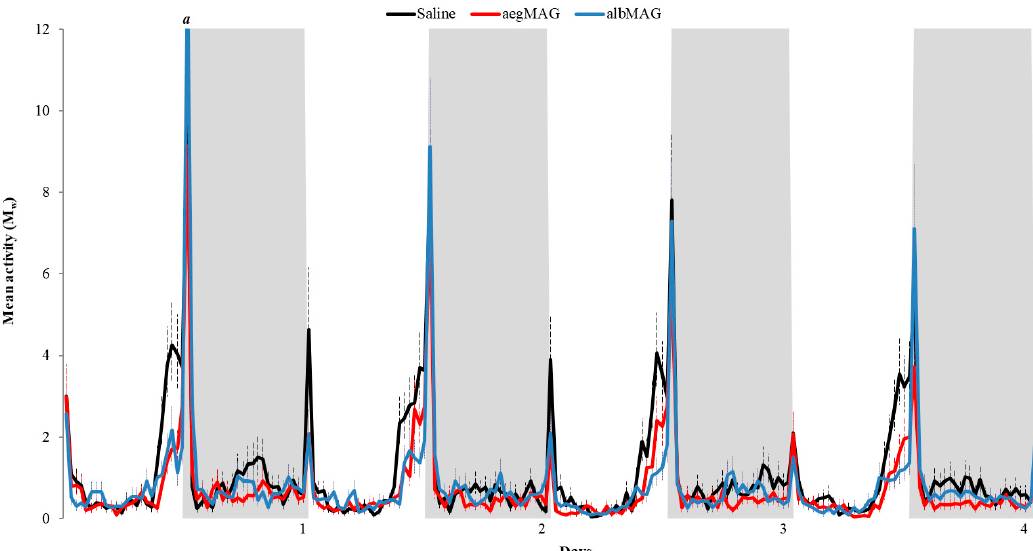
Figure 1. William’s mean (M w ) of locomotor activity of Aedes albopictus virgin females injected with saline (black line-control group; n = 63), male accessory gland (MAG) of Ae. aegypti (red line; n = 70) and MAG of Aedes albopictus (blue line; n = 74) exposed to four days of 12 h of light (white columns) and 12 h of dark (grey columns) (light/dark 12:12) at 25 °C. Dotted bars represent 1 standard error of the M w . A reading exceeding the scale is indicated with the letter a and its value is a = 13.48 (+1.92).